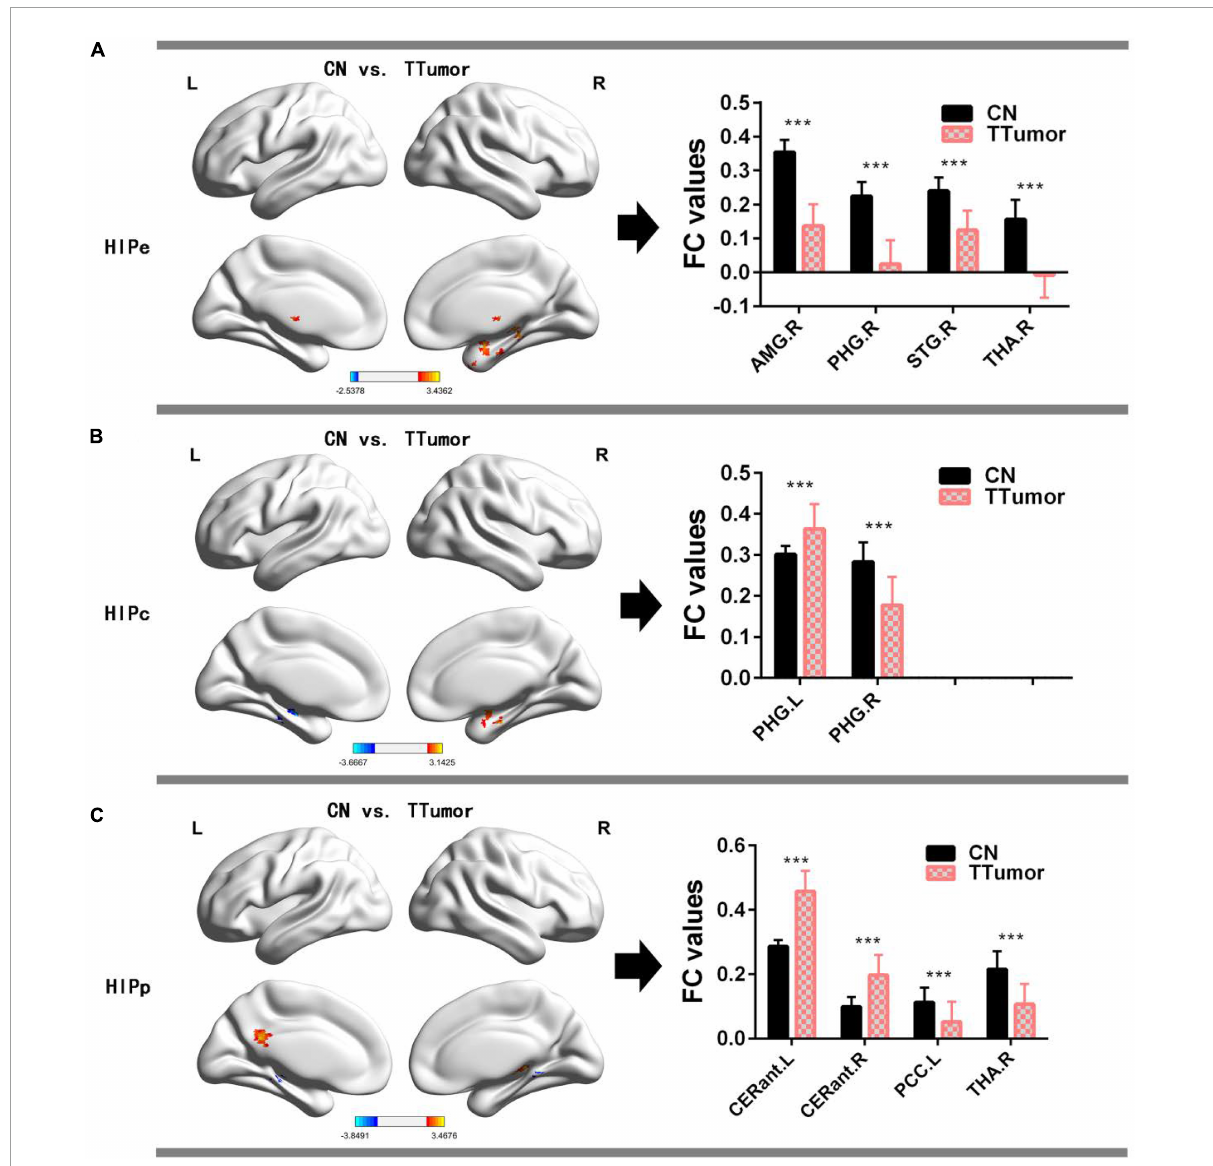
FIGURE2 Comparison of FC within the hippocampal subnetworks between CN and TTumor subjects before surgery in the first cohort. (A) Altered regions of FC within the HIPe subnetwork in TTumor patients compared to CN. The bar chart on the right shows the quantitative comparison of FC within these altered regions; *** p < 0.001. (B) Altered regions of FC within the HIPc subnetwork in TTumor patients compared to CN. The bar chart on the right shows a quantitative comparison of FC within these altered regions; *** p < 0.001. (C) Altered regions of FC within the HIPp subnetwork in TTumor patients compared to CN. The bar chart on the right shows the quantitative comparison of FC within these altered regions; *** p < 0.001. CN, healthy controls; TTumor, patients with temporal tumor (glioma); HIPe, hippocampal emotional region; HIPc, hippocampal cognitive region; HIPp, hippocampal perceptual region; AMG.R, right amygdala; PHG.R, right parahippocampal gyrus; STG.R, right superior temporal gyrus; THA.R, right thalamus; PHG.L, left parahippocampal gyrus; CERant.L, left cerebellum anterior lobe; CERant.R, right cerebellum anterior lobe; PCC.L, left posterior cingulate cortex; L, left hemisphere; R, right hemisphere; FC, functional